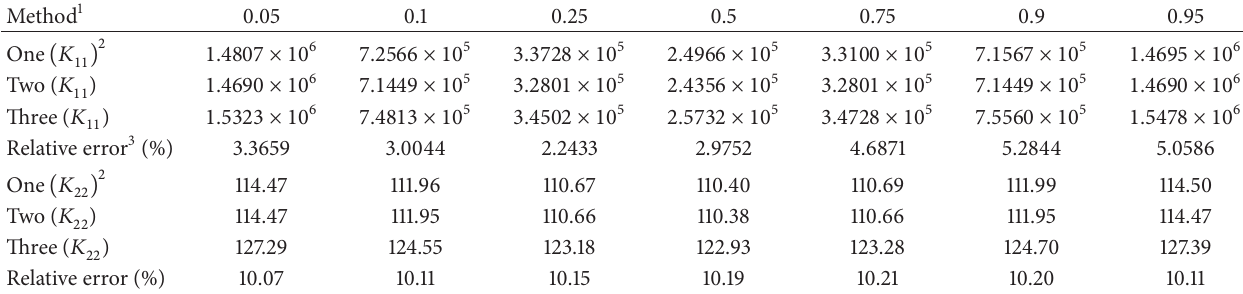
Table 2: Comparison of values of dynamic stiffness at different locations.